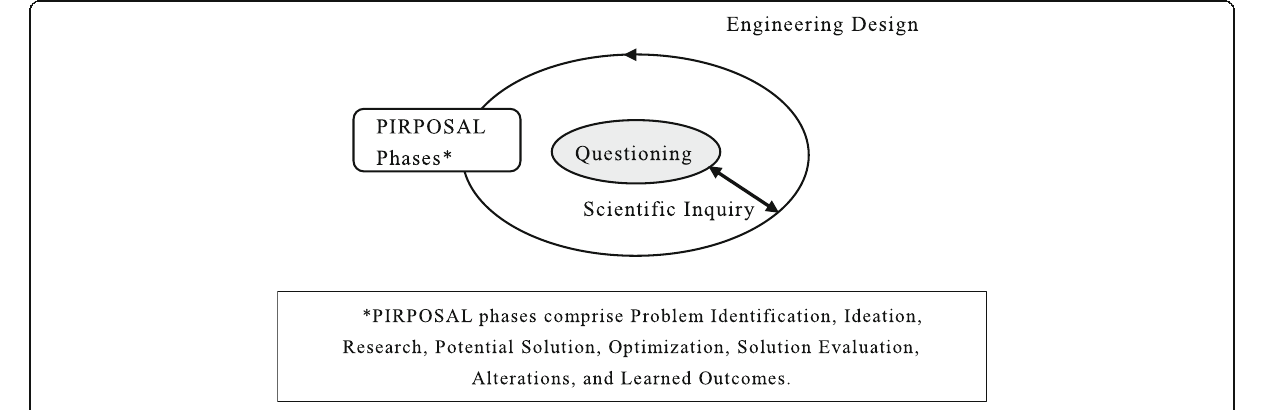
Fig. 2 PIRPOSAL model simplified by the authors with reference to Wells (2016)